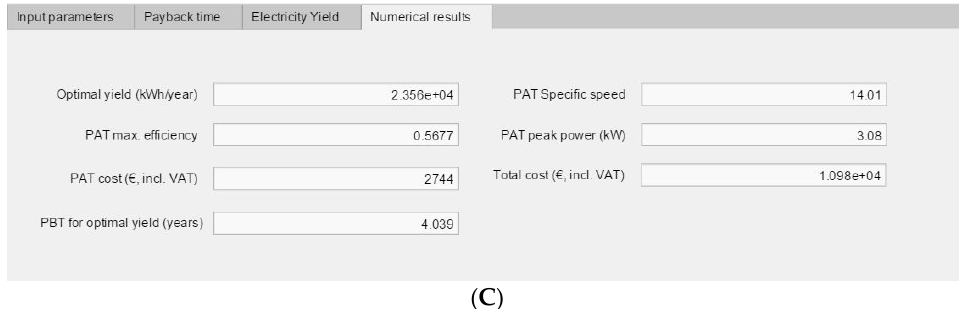
Figure 6. Results of the PAT selection software applied to the Connells supply line at Blackstairs WTP. ( a ) Expected yearly energy yield. ( b ) Expected payback time. ( c ) Summary of the numerical results.